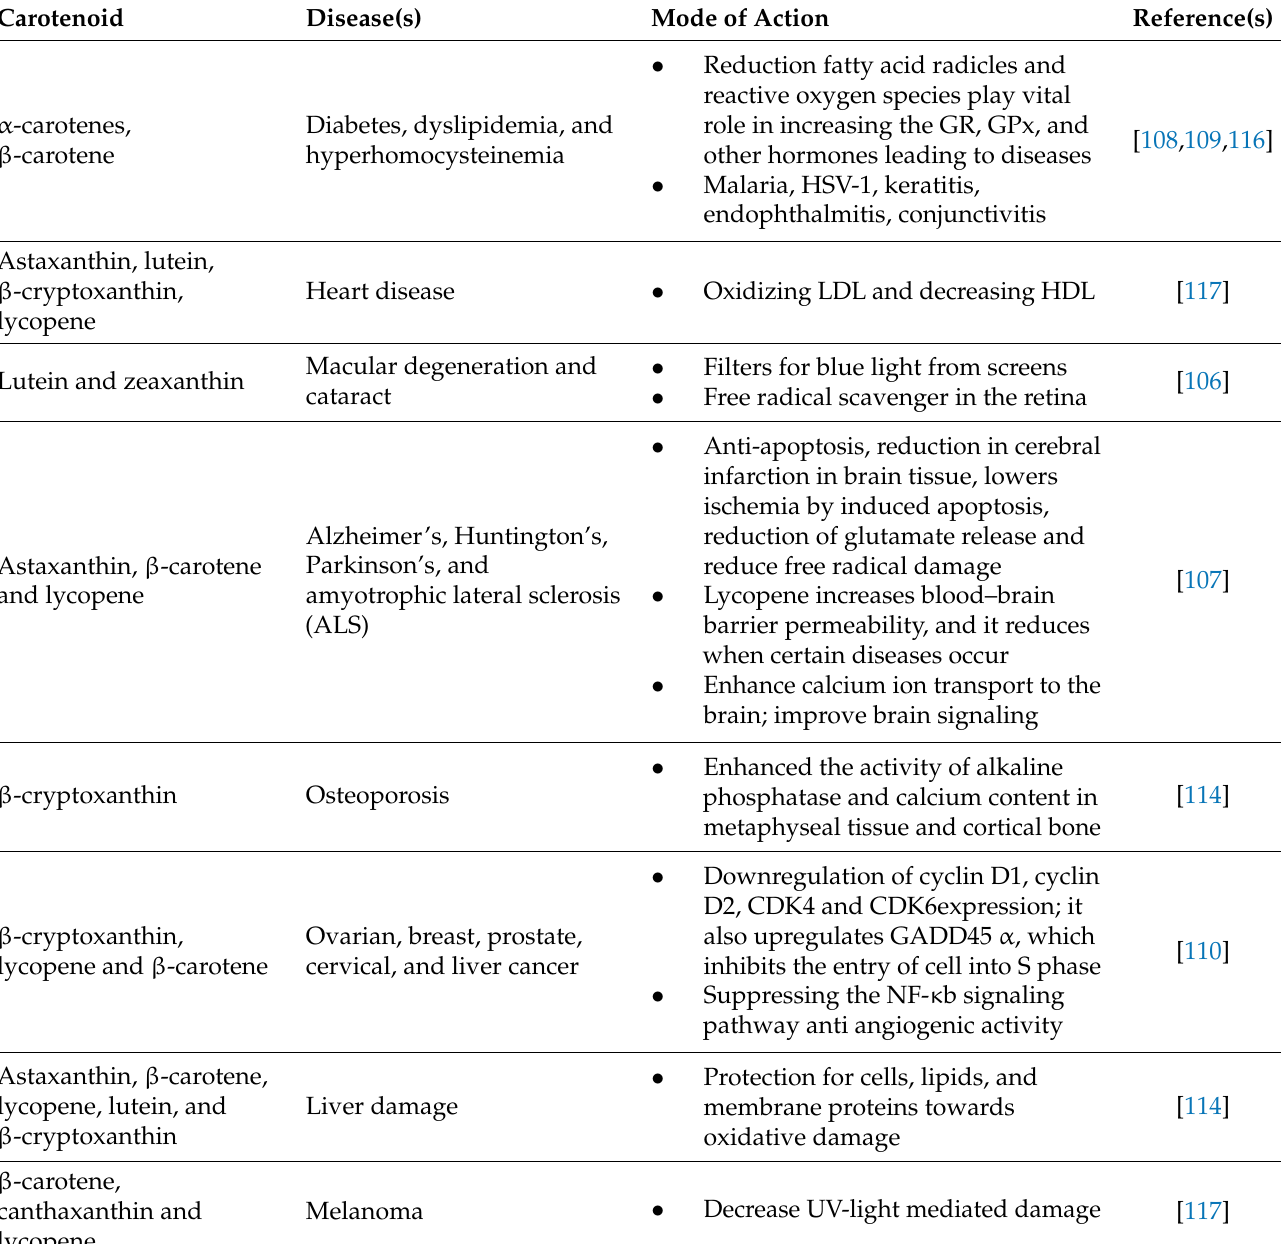
Table 1. The role of different carotenoids in disease